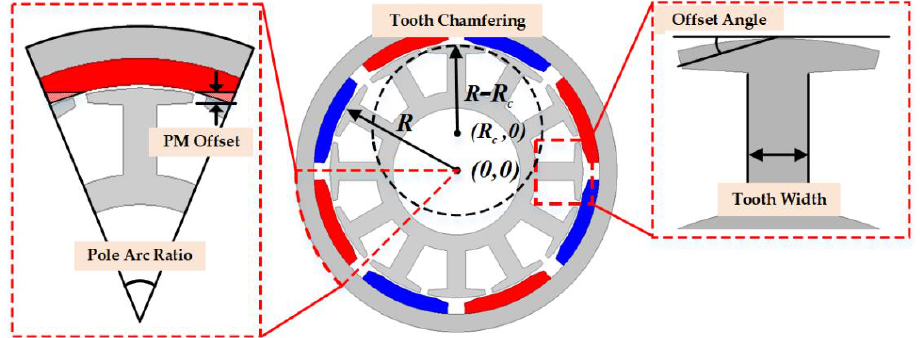
Figure 4. Design Figure 4. Design variables.